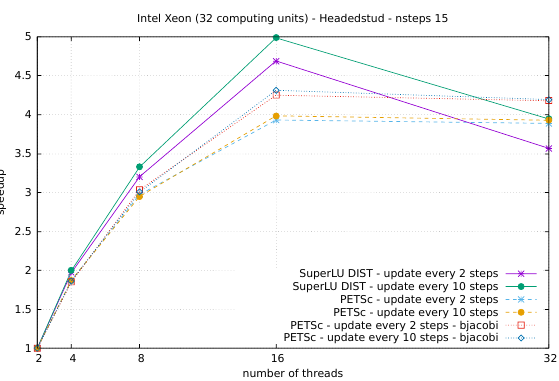
Figure 10. Speedups using the Modified Newton- Raphson method with secant stiffness updated after every 2nd and 10th iteration.